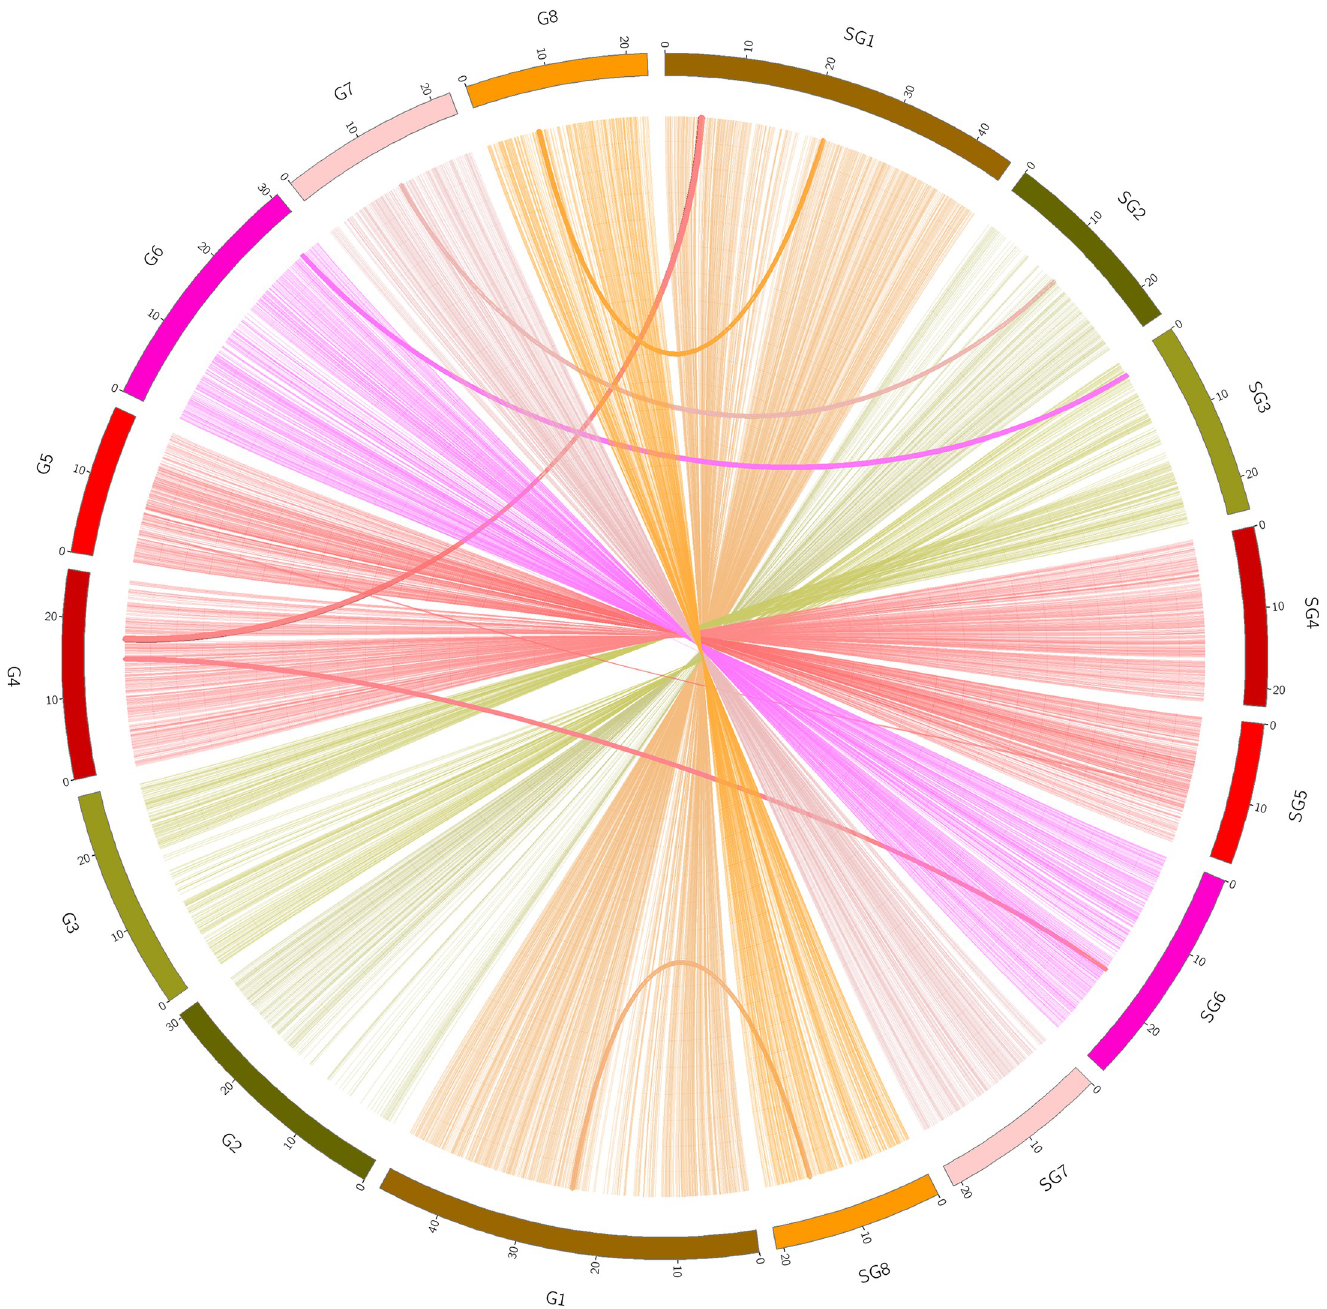
Fig 2. Syntenic blocks of P. persica (G1-8) and P . persica cv. ‘Sovetskiy’ (SG1-8) . Homologous regions of two peach genomes are connected by colored lines representing syntenic regions identified by NUCmer and mapped using Circos software.